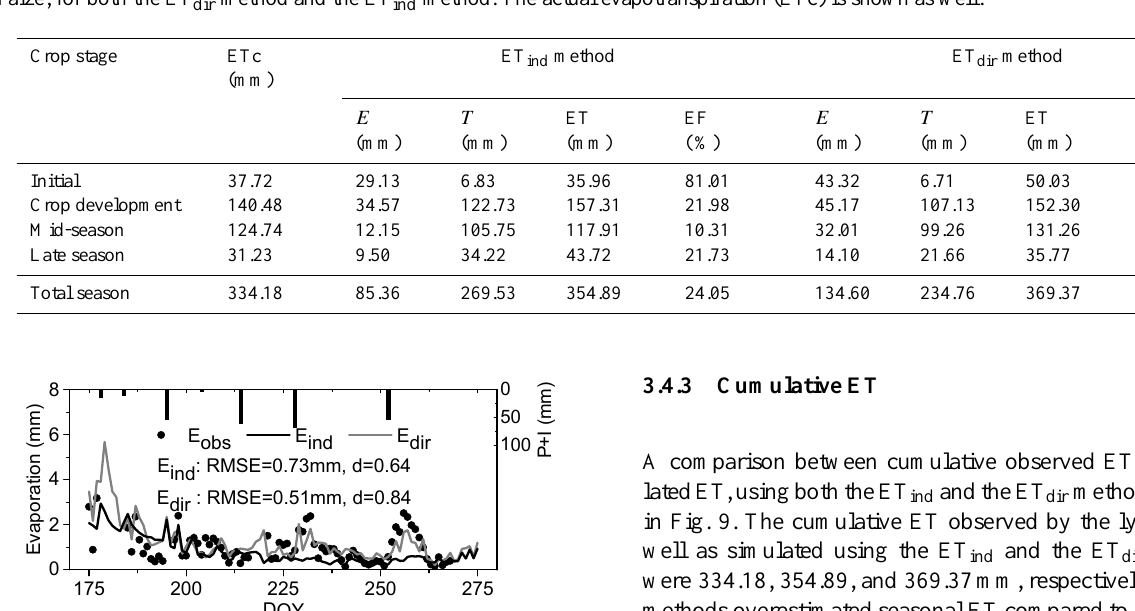
Figure 7. Daily variation in observed ET and simulated ET, based on the ET ind method (a) and the ET dir method (b) . On the right: the regression between observed and simulated ET for the ET ind method (above) and the ET dir method (below). Table 4. Evaporation ( E ), transpiration ( T c ) , evapotranspiration (ET), and evaporation fraction ( E /ET, EF) for each development stage of maize, for both the ET dir method and the ET ind method. The actual evapotranspiration (ETc) is shown as well.